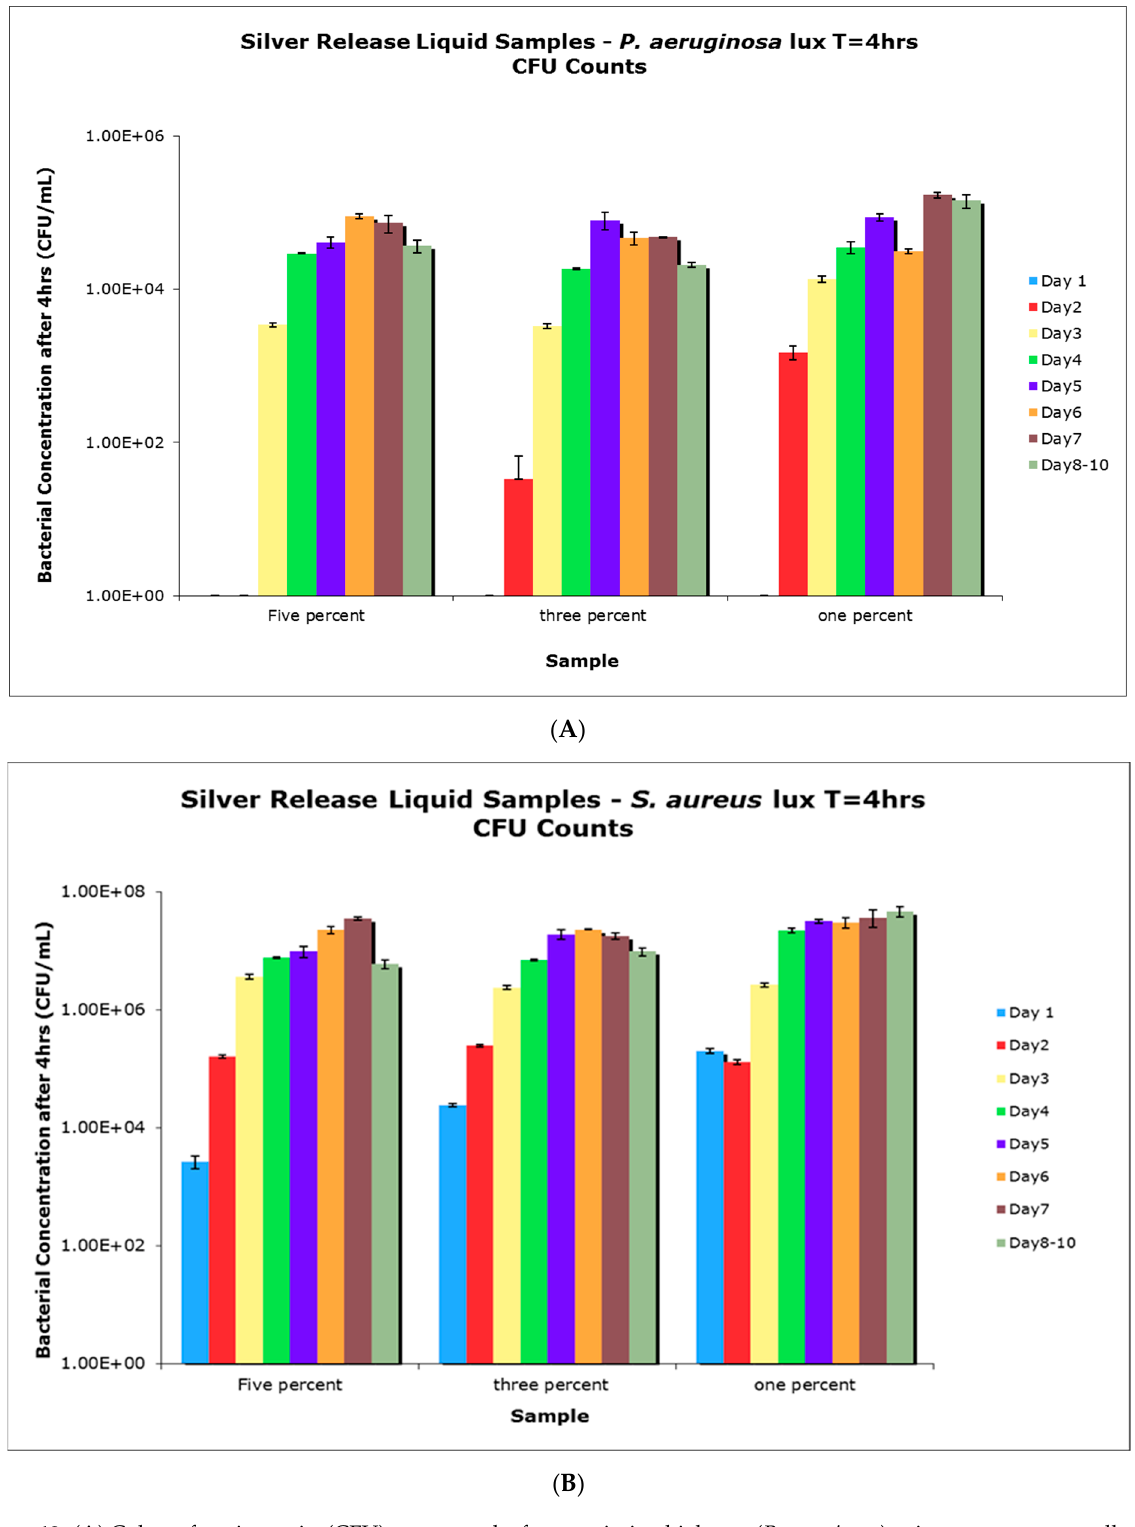
Figure 12. ( A ) Colony-forming units (CFU) count results from antimicrobial tests ( P. aeruginosa ) using supernatants collected from incubation of PVA/silver films over a 10-day period; ( B ) CFU count results from antimicrobial tests ( S. aureus ) using supernatants collected from incubation of PVA/silver films over a 10-day period.